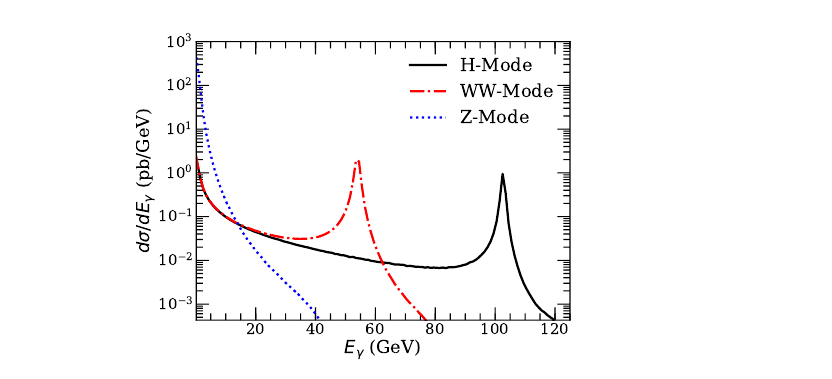
Figure 4 . Di(cid:11)erential cross section for the irreducible standard model background process e + e (cid:0) ! (cid:23) (cid:22) (cid:23)(cid:13) . We compute the SM cross sections using FeynAtrs [29] and FormCalc [30] packages